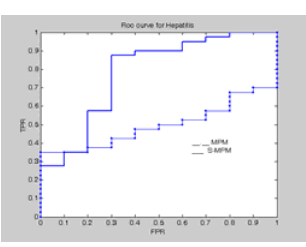
Fig. 1. ROC curves of Sonar.